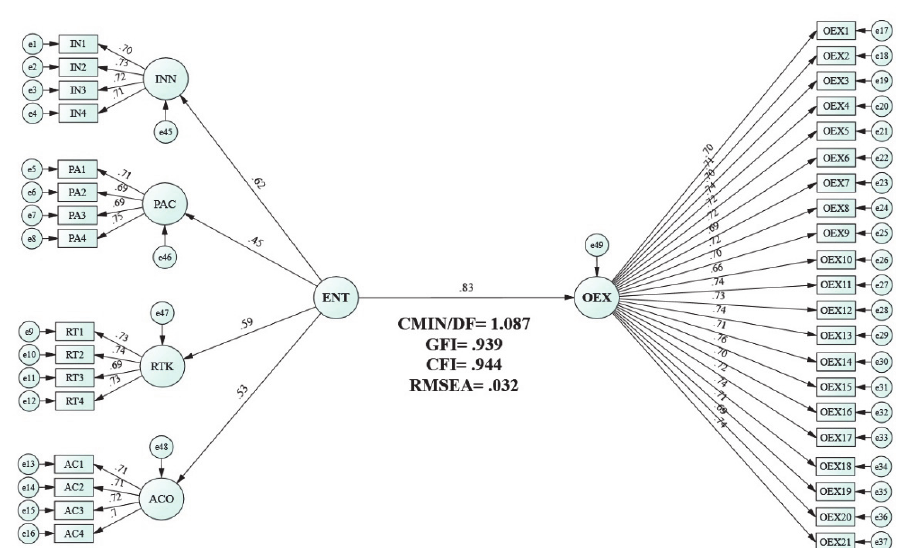
Fig. 3. Structural equation modeling to test the impact of entrepreneurship on organizational